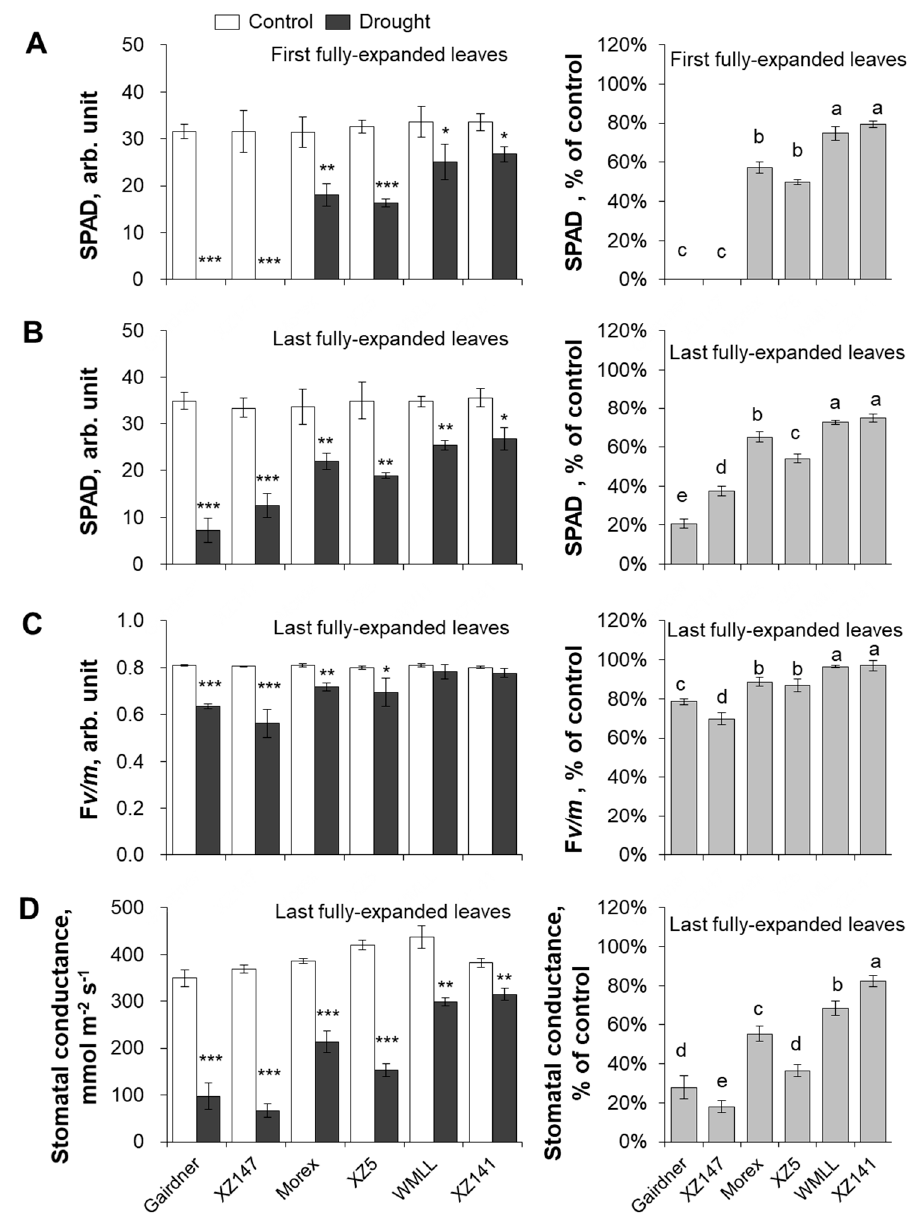
Figure 2. E ff ect of water-limited drought stress on photosynthetic parameters of barley seedlings. Twelve-day-old barley seedlings were subjected to drought stress. Plants were measured for SPAD values of the first ( A ) and last ( B ) fully-expanded leaves, F v / m of last fully-expanded leaf ( C ) and stomatal conductance of last fully-expanded leaf ( D ) at 10 d after onset of treatments. Vertical bars represent means ± SE of five replicates. Asterisks indicate the significant di ff erence between treatments at * p < 0.05, ** p < 0.01 and *** p < 0.001. Di ff erent lowercase letters indicate the significant di ff erence between genotypes at p < 0.01.